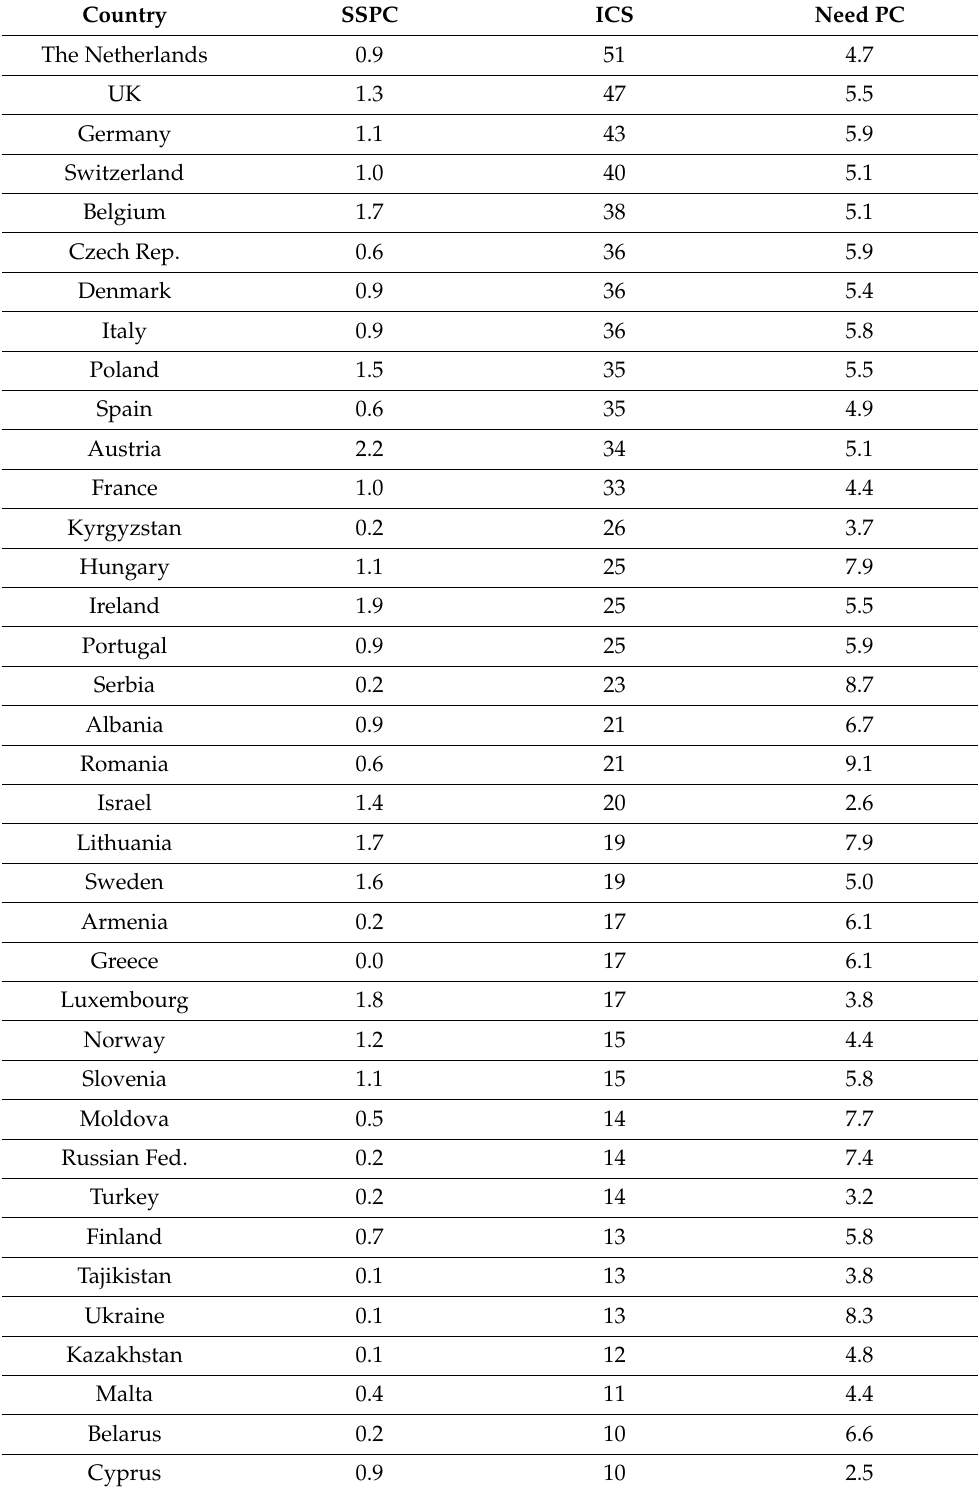
Table 1. Descriptive statistics for the variables: Integration Capacity Score (ICS), Specialized Services in Palliative Care per 100,000 inh. (SSPC), and Palliative Care